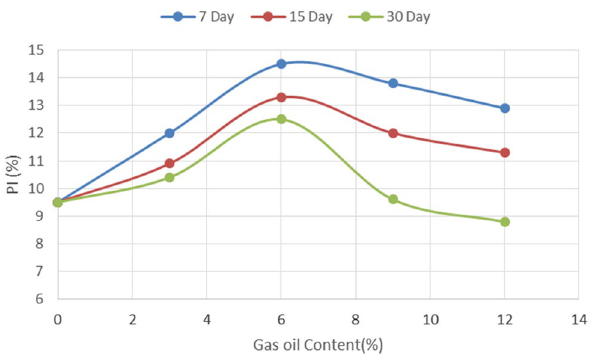
Fig. 9 Plasticity index variation in different curing times and differ- ent percentages of gasoline in fine-grained